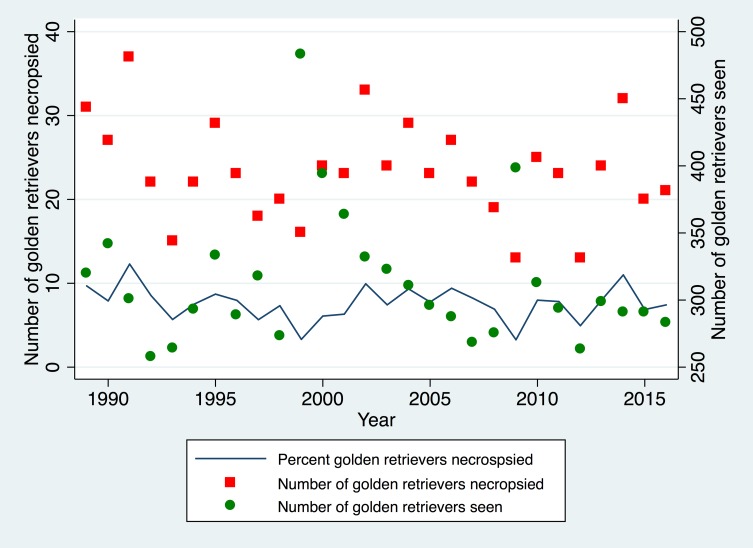
Golden retriever dogs seen and undergoing necropsy.Scatter plot showing in green circles the total number of golden retrievers per year undergoing necropsy exam and in red squares the total number of golden retrievers seen in the hospital per year. The solid line represents the percentage of golden retrievers undergoing necropsy divided by the total golden retriever animals seen that year.